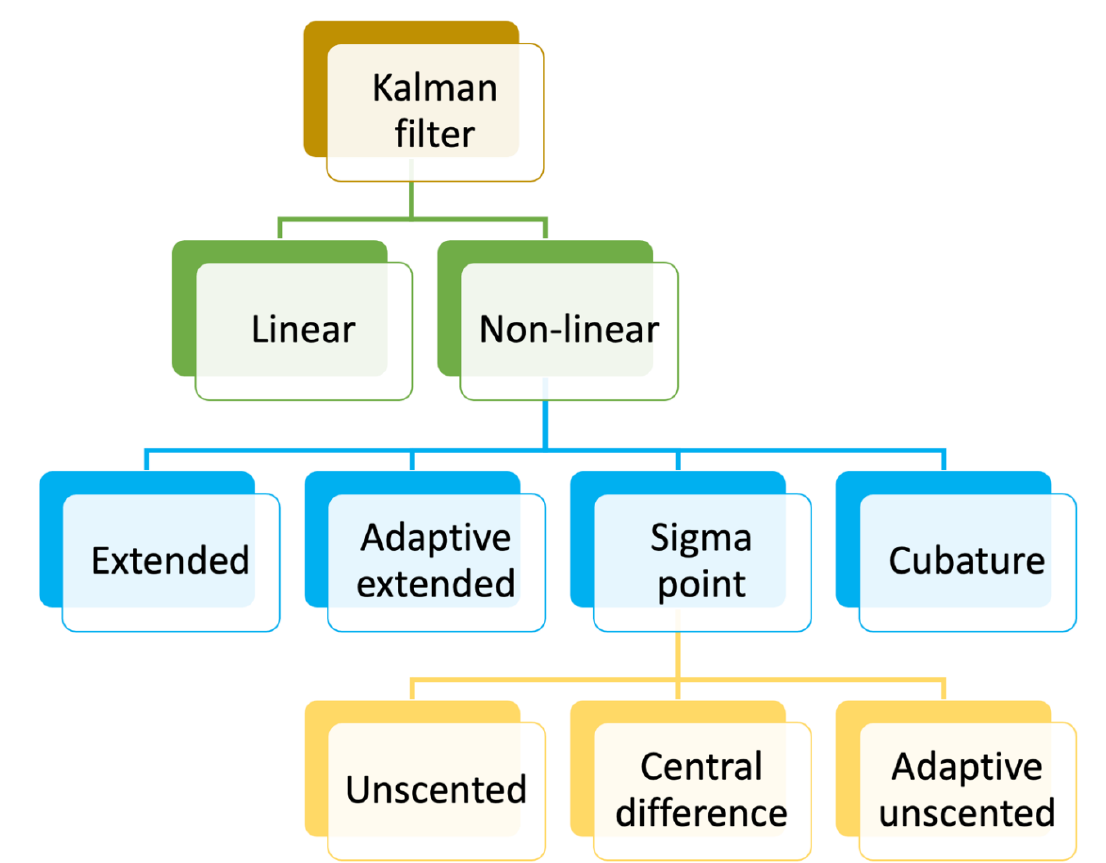
Figure 4. The Kalman filter family of algorithms that have been used for state-of-charge estimation in battery electric vehicle Lithium-ion batteries.